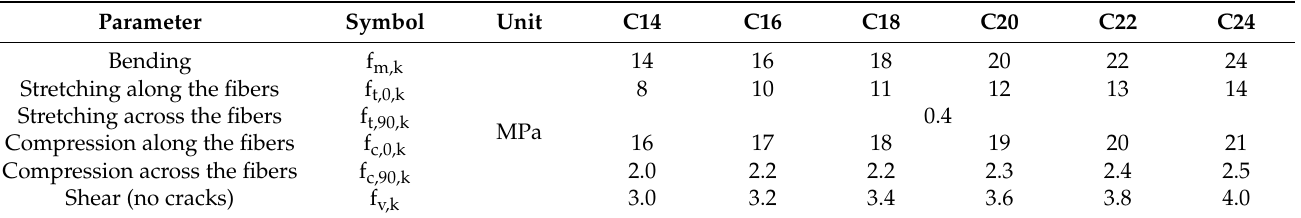
Table 3. Characteristic strength values of softwood